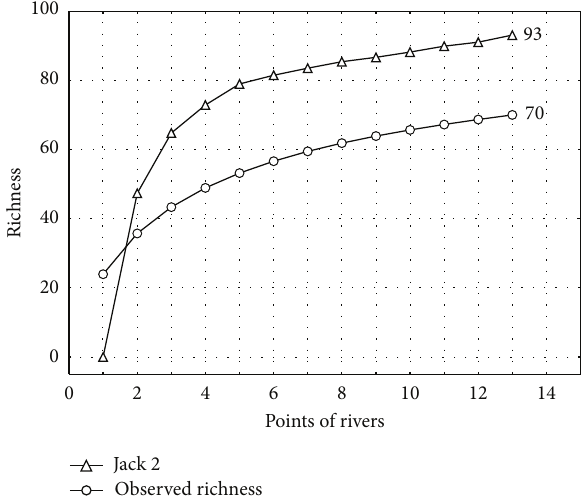
Figure 3: Observed and estimated regional richness in the study area. The nonparametric estimation was obtained by the nonpara- metric estimator Jackknife 2 (Jack